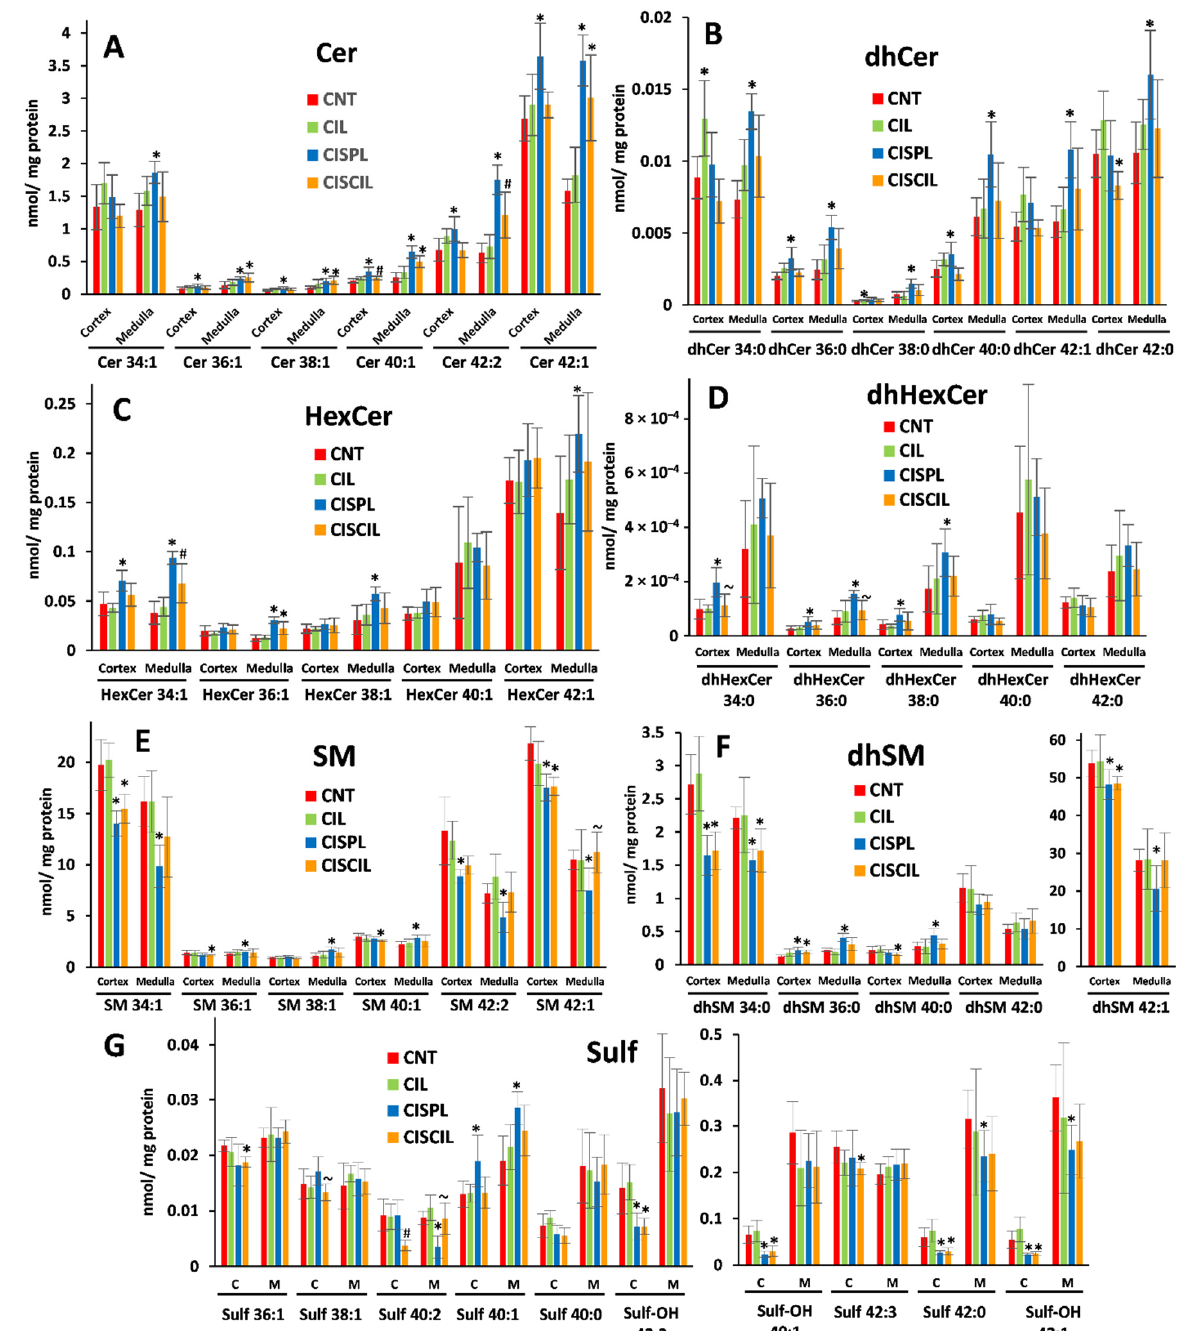
Figure 4. Sphingolipid species found in the renal cortex and medulla in CNT, CIL, CISPL, and CISCIL groups. ( A ) Ceramides (Cer). ( B ) Dihydroceramides (dhCer). ( C ) Hexosylceramides (HexCer). ( D ) Dihydrohexosylceramides (dhHexCer). ( E ) Sphingomyelins (SM). ( F ) Dihydrosphingomyelins (dhSM). ( G ) Sulfatides (Sulf). * p < 0.05 vs. CNT. ~ p < 0.05 vs. CISPL. # p < 0.05 vs. CNT and CISPL. FDR < 0.1 was considered. Data are presented as the mean ± sd; n = 6 animals per group.